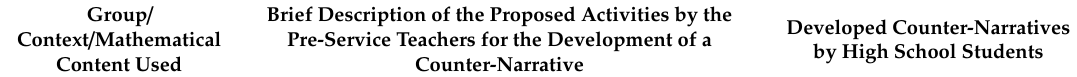
Table 3. Group, context, mathematical content, proposed activities, and